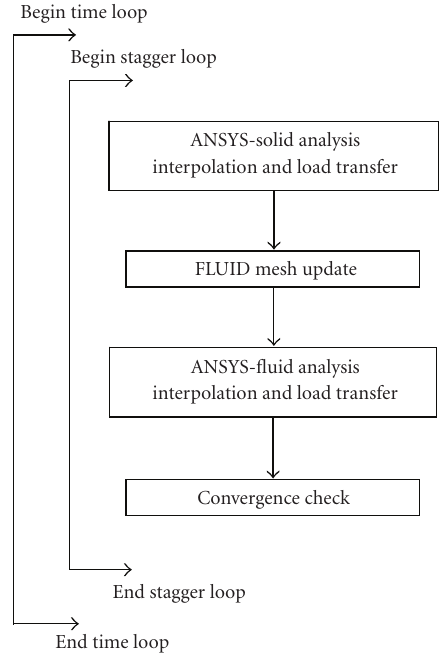
Figure 1: A diagram of fluid-structure-interaction